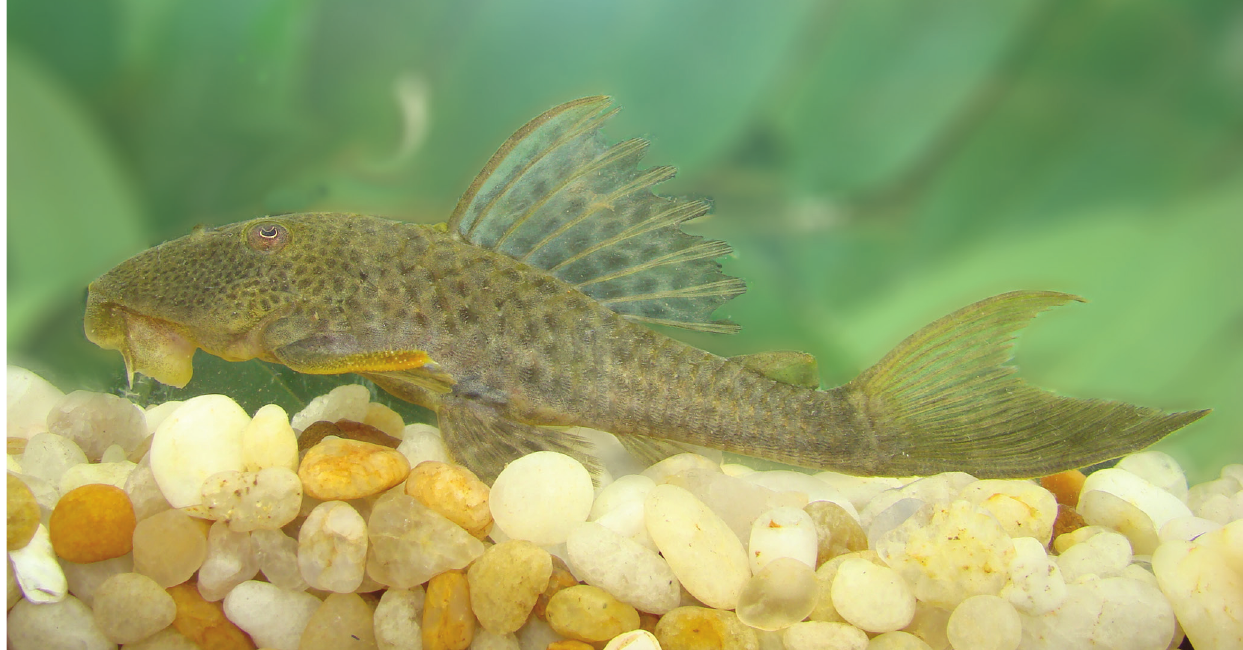
Fig. 2. Photograph of a fresh specimen of Hypostomus johnii (UFRN 1800, 116.0 mm SL) from the rio Guaribas, municipality of Picos, state of Piauí, Brazil (photographed immediately after